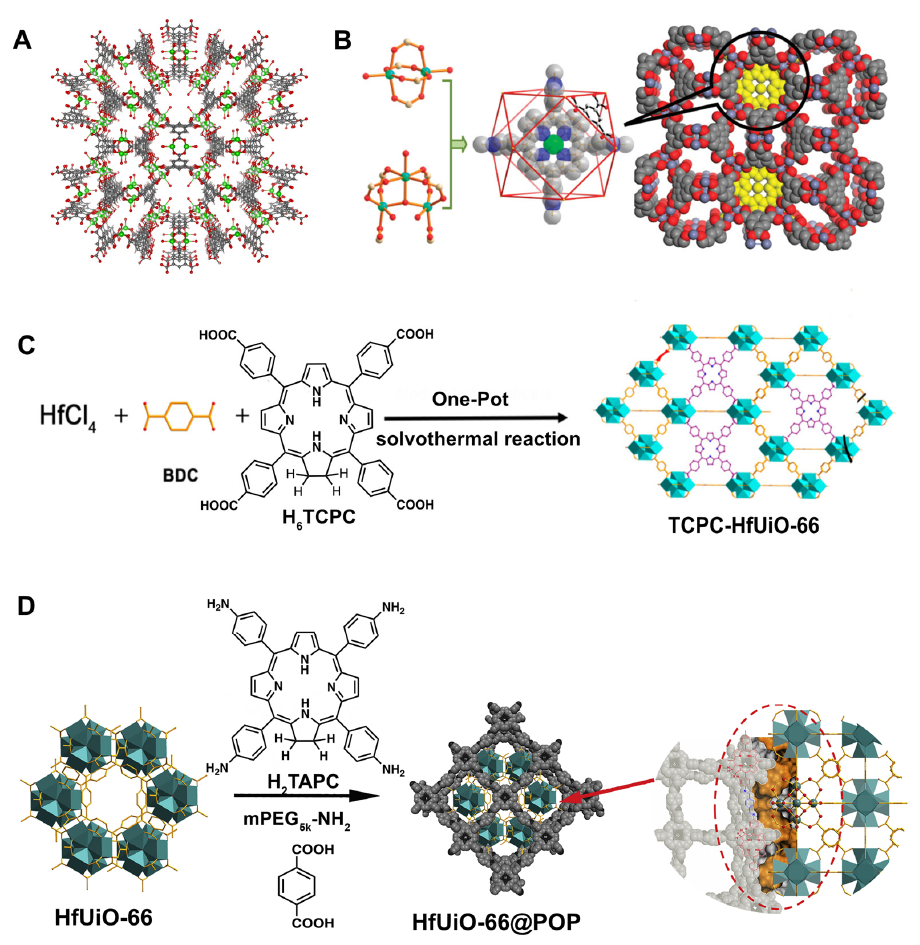
Figure 4. ( A ) Crystal structure of ZnMOF projected along the c axis (green: Zn, Grey: Carbon, Red: Oxygen); ( B ) The two molecular secondary building blocks in ZnTMPyP + @ZnMOF, Porphyrin cation located in an octahemioctahedral cage and space-filling model of ZnTMPyP + @ZnMOF projected along the c axis; ( C ) Synthesis of H 2 TCPC-HfUiO-66; ( D ) Synthesis of HfUiO-66@POP nanocomposite. Reprinted/adapted with permission from Refs.